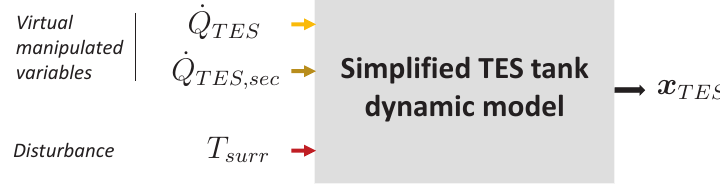
Figure 4. Simplified model of the TES-backed-up refrigeration